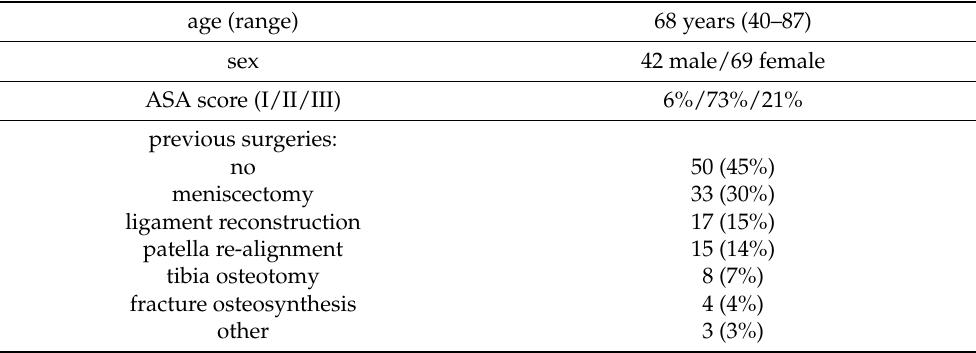
Table 1. Patients’ demographics of total collective.